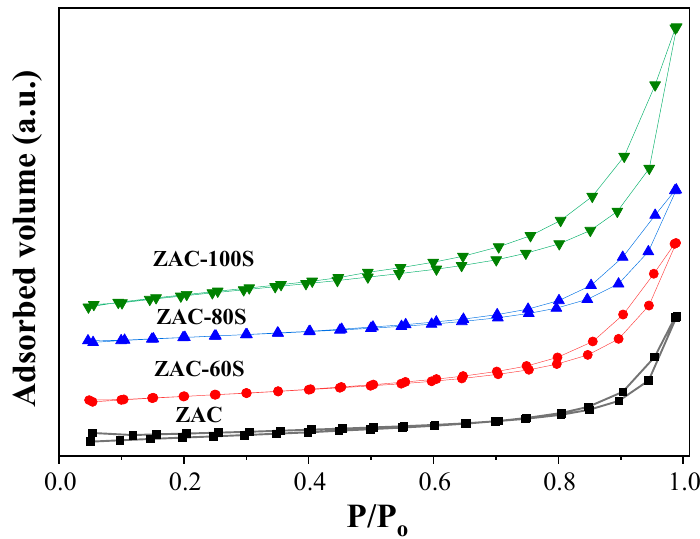
Figure 6. N 2 physisorption isotherms for the ZnAlCd sulfured